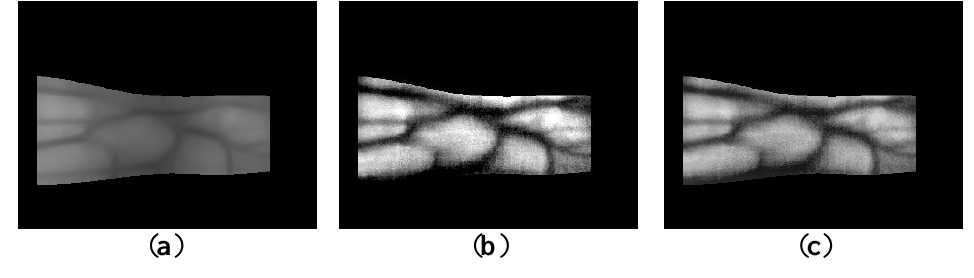
Figure 24. Enhanced images obtained using the proposed method with four-directional Gabor filtering and Retinex filtering with a sigma value of 15 using images from database II: ( a ) Gabor filtered image; ( b ) Retinex filtered image with a sigma value of 15; and ( c ) Fuzzy FOM based on the Max